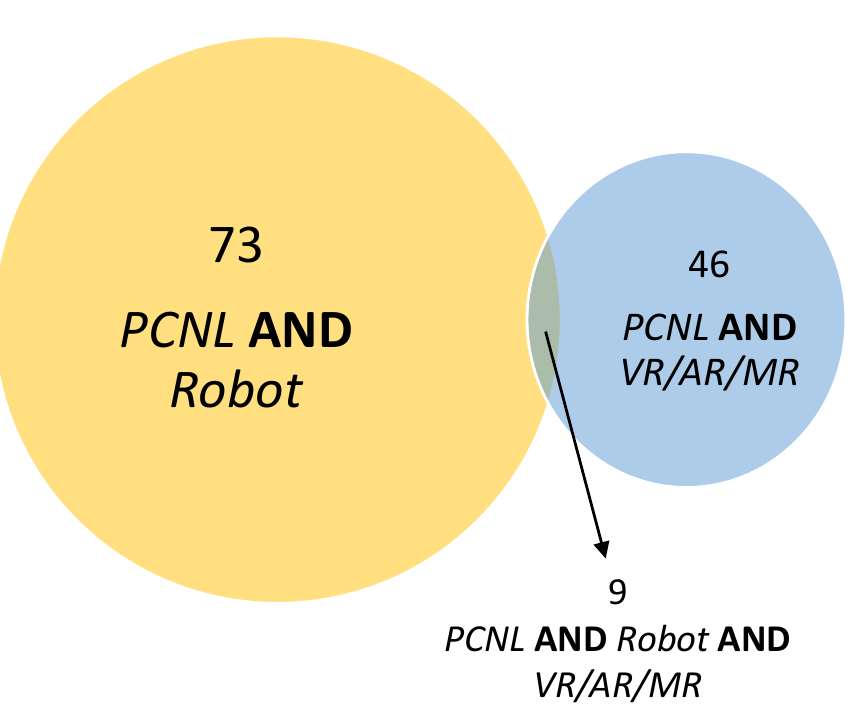
Figure 1. Queries results: the number of contributions in which PCNL is related to virtual/augmented reality (46: blue circle) and robotics (73: yellow circle). The intersection contains 9 contributions. Source: Web of